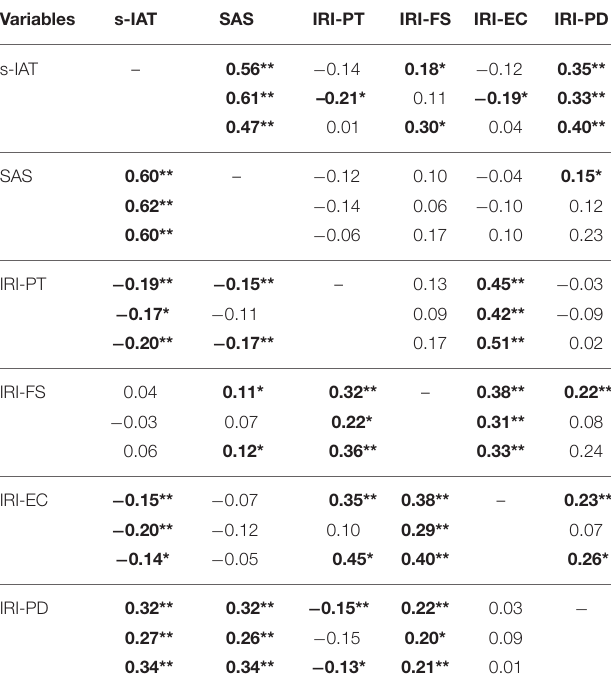
TABLE 2 | Partial correlations between digital use variables (s-IAT, SAS) and IRI empathy variables for the complete samples controlling for gender (top line). Correlations are also presented for each variable seperated by gender (female: middle line; male: bottom